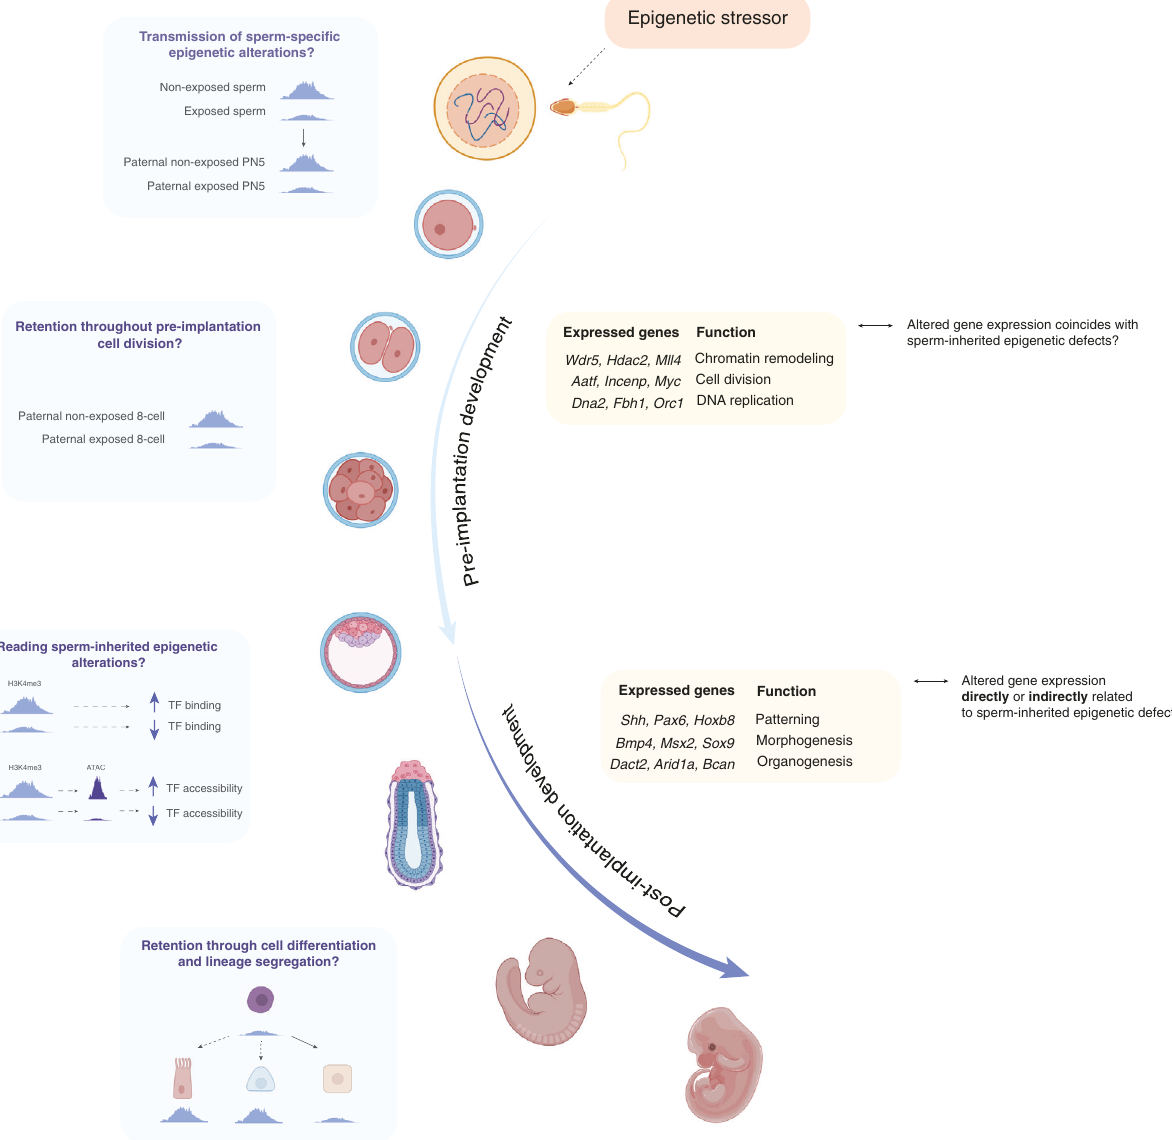
Fig. 4 | Moving from association to function in the fi eld of paternal epigenetic inheritance. Overview of remainingquestions thatwillpermit the fi eldof